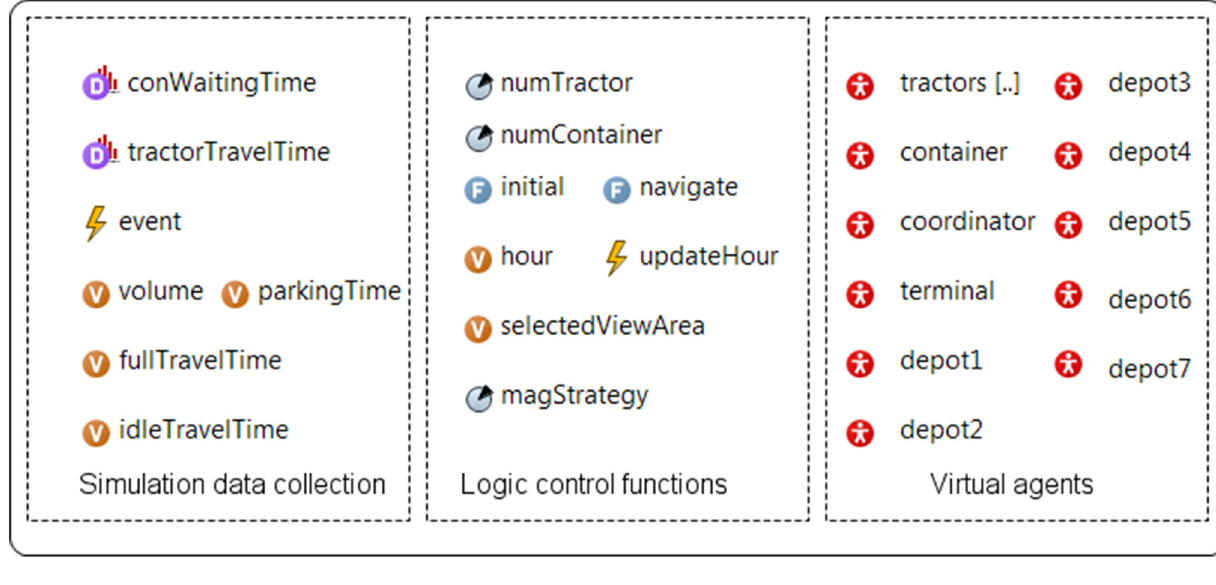
Fig. 3 Construction of the simulation model